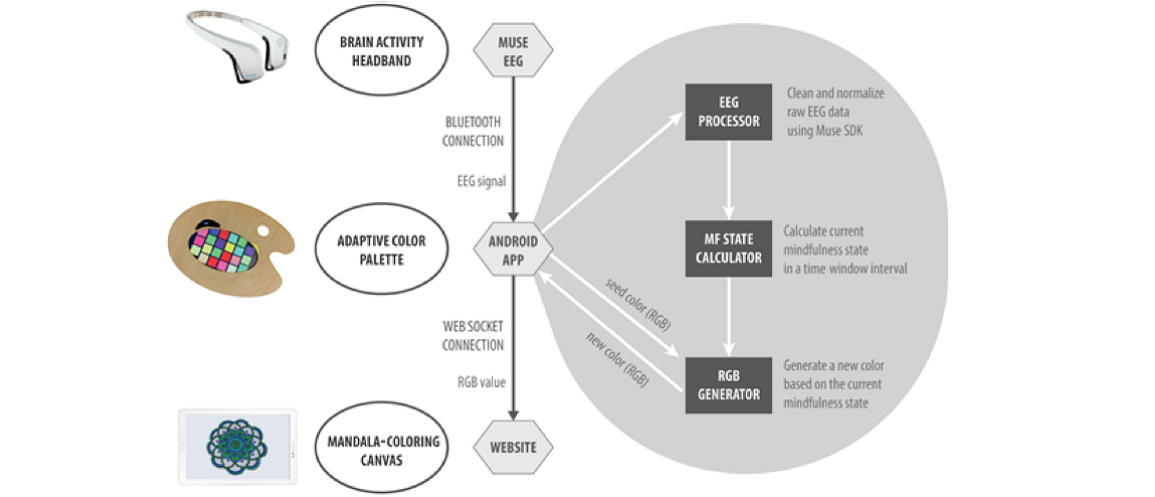
Figure 1. This diagram shows an overview of the system by describing the 3 components of Anima (ie, brain activity headband, adaptive color palette, and mandala-coloring canvas) and their integration. EEG: electroencephalogram; MF: mindfulness; RGB: red, green, and blue; SDK: software development